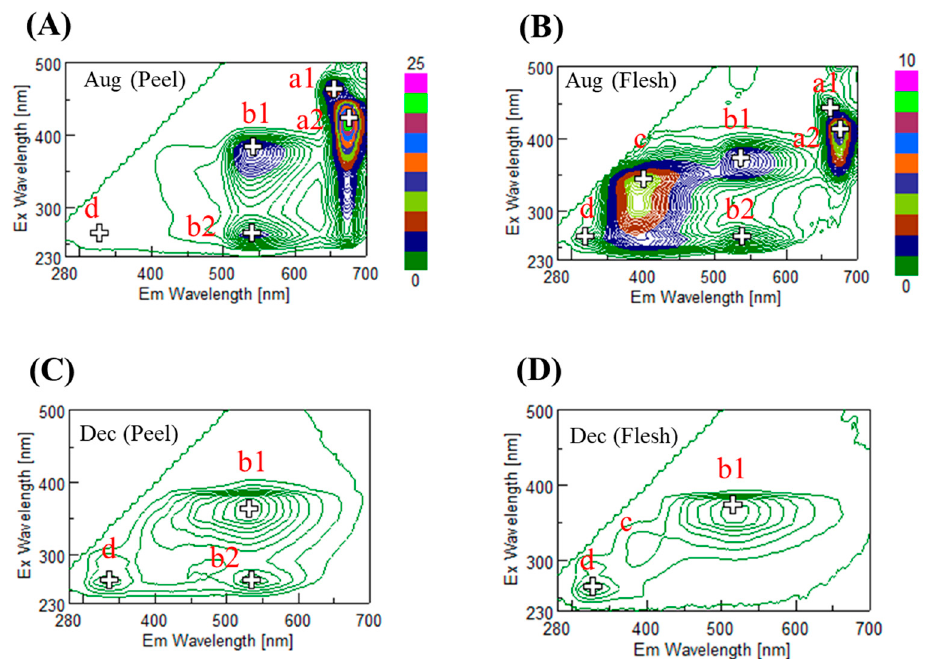
Figure 4. Fluorescence excitation and emission matrices (EEM) of Satsuma mandarin during the maturing period from August to December: ( A ) peel in August; ( C ) in December; ( B ) flesh in August; ( D ) in December. The color bars show the fluorescent intensity in Raman units.